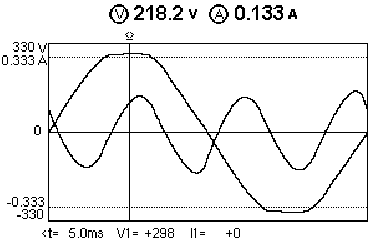
Figure 16. The phase voltage and the neutral current when all the three compact fluorescent lamps are supplied at different phases L 1 , L 2 , L 3 and neutral conductor (set 4).